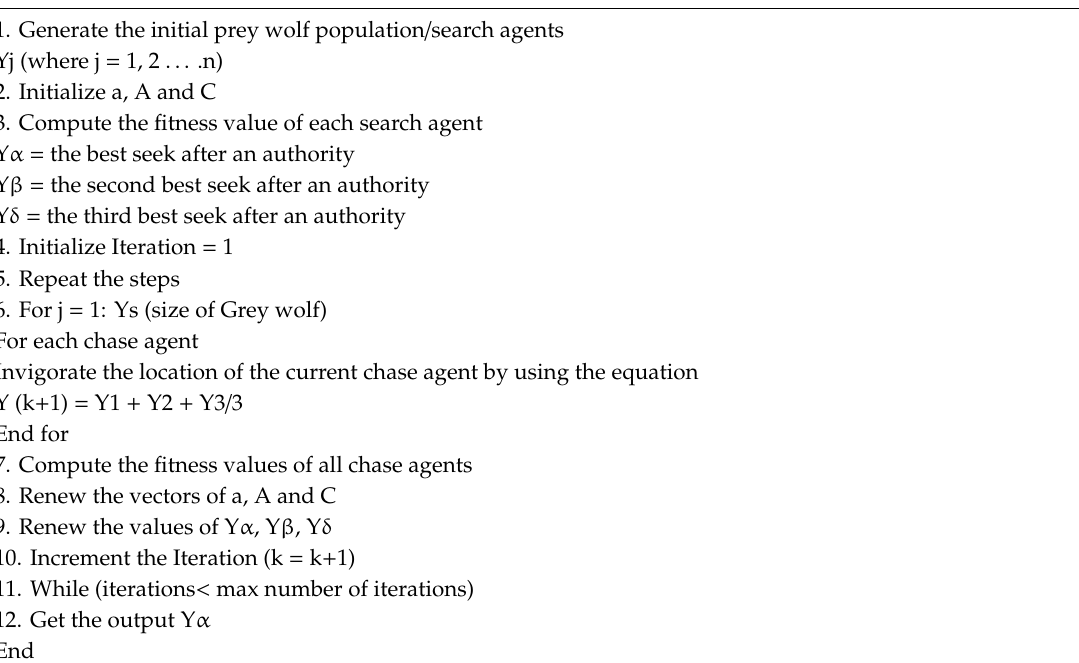
Algorithm 1. Grey Wolf Optimizer (GWO)